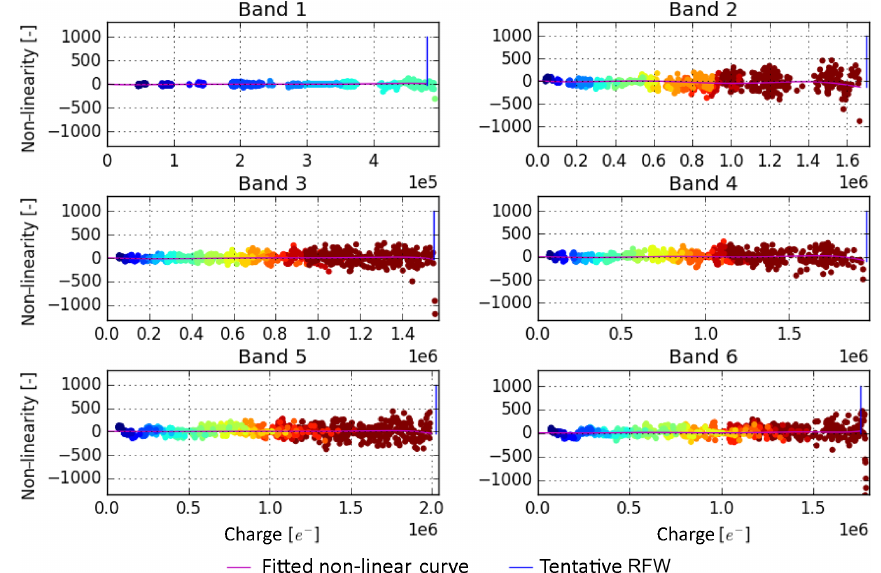
Figure 8. The obtained non-linearity curve for all bands (purple line) together with the scatter plot of the individual non-linearity tuples after double processing. Each colour indicates a sub-cloud from the pixels of an individual measurement with a certain exposure time. The blue vertical line indicates the limit chosen for the validity of the correction; this is the value for register full well. The double-processed data show that the non-linearity correction removes the non-linearity from Fig.